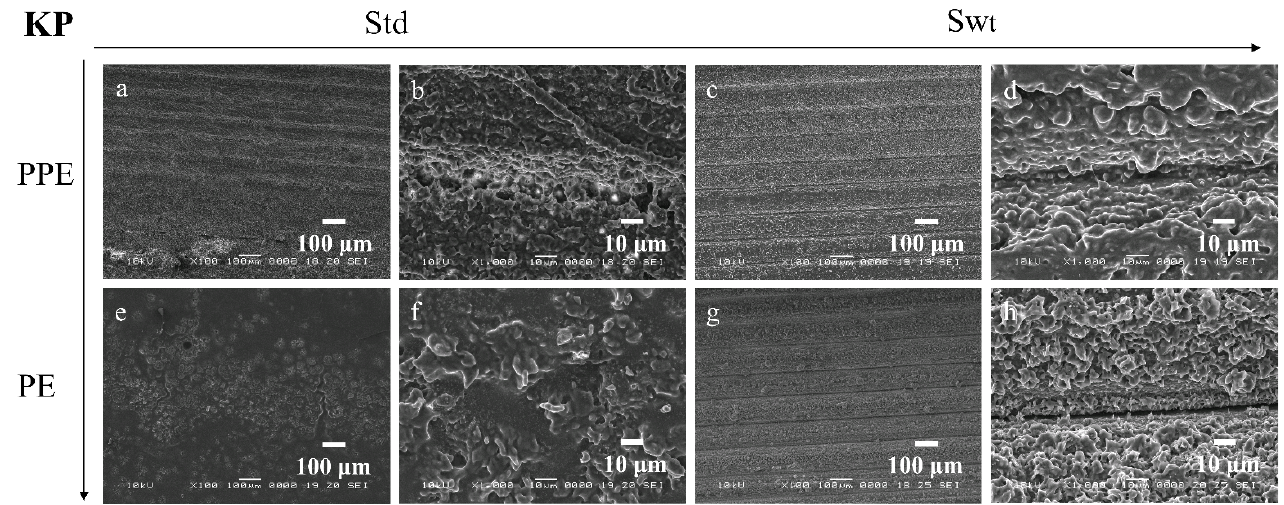
Figure 12. SEM images of KP biofilms in standard ( a , b , e , f ) and switched ( c , d , g , h ) samples on ( a ) × 100, ( b ) × 1000, ( c ) × 100 and ( d ) × 1000 PPE side; ( e ) × 100, ( f ) × 1000, ( g ) × 100, and ( h ) × 1000 PE side of the channel.